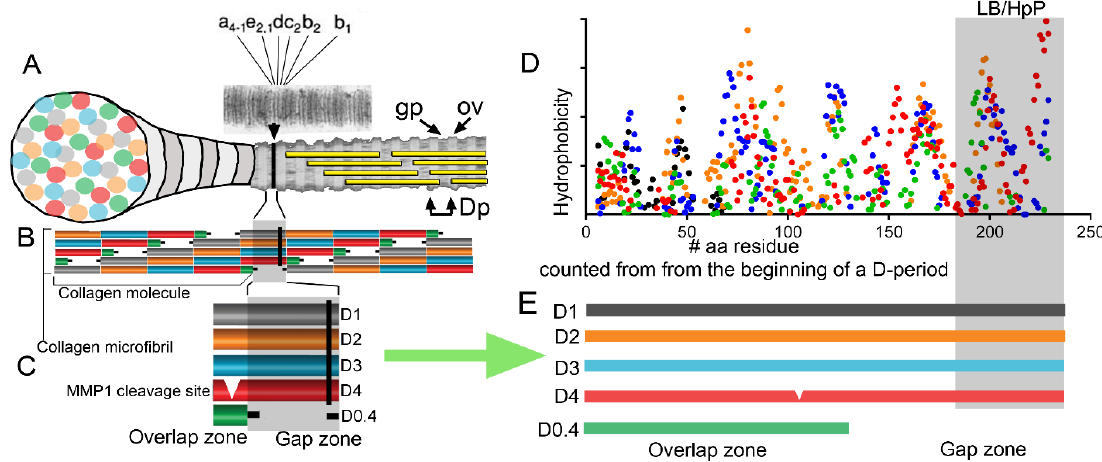
Figure 3. A schematic explaining the formation of the fibril-specific features formed due to aggregation of individual collagen molecules. The schematic illustrates the formation of the hydrophobic cluster (indicated by the black line ( | ) across the fibril in A , B , and C ). ( A ) A banding pattern of a positively stained collagen fibril. Defined bands (a, b, c, d, and e) are indicated. Please note that the hydrophobic cluster is located between c2 and d bands. Gaps (gp), overlaps (ov), and D-period (Dp) regions are visible. ( B , C ) Detailed representation of the gap and overlap zones with the hydrophobic cluster indicated as a black line ( | ). Additionally, MMP1 cleavage site present in the D4 period is indicated. ( D ) A hydrophobicity plots of overlapping D-periods ( C , E ) [19]. The highlighted zone indicates the unique lipid-binding (LB) region studied here and characterized by poor content of hydroxyproline residues (HpP). This zone corresponds to the region indicated by the black line ( | ) in ( A ), ( B ), and ( C ).